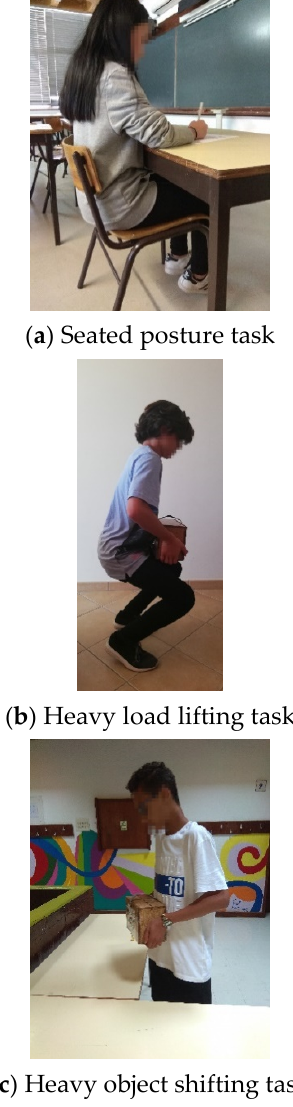
Figure 1. Representation of ( a ) seated posture, ( b ) heavy load lifting, and ( c ) heavy object shift- ing